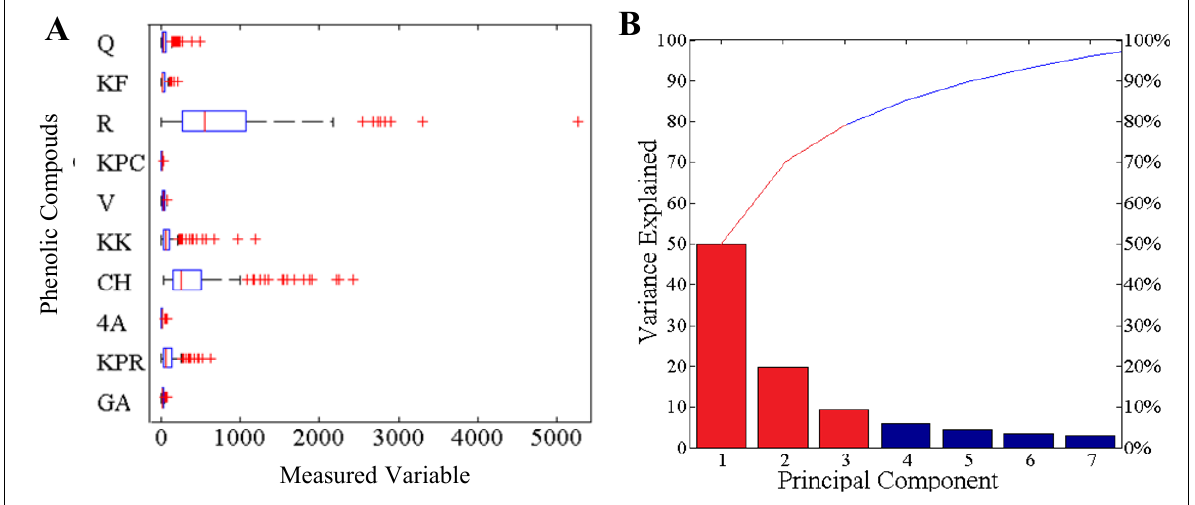
Figure 4. Content of GA-gallic acid; KPR-protocatechuic acid; 4A- p -aminobenzoic acid; CH-chlorogenic acid; KK-caffeic acid; V-vanillin; KPC-p-coumaric acid; R-rutin; KF-ferulic acid; Q-quercetin. For the determination of HPLC profile of individual apricot cultivars, high performance liquid chromatography with electrochemical and UV-VIS detection was used. ( A ) Box plot graphs of range values of content of polyphenol of interest (µM, the average, mean and variance are expressed); ( B ) Representation of the content of polyphenols by the use of ten principal